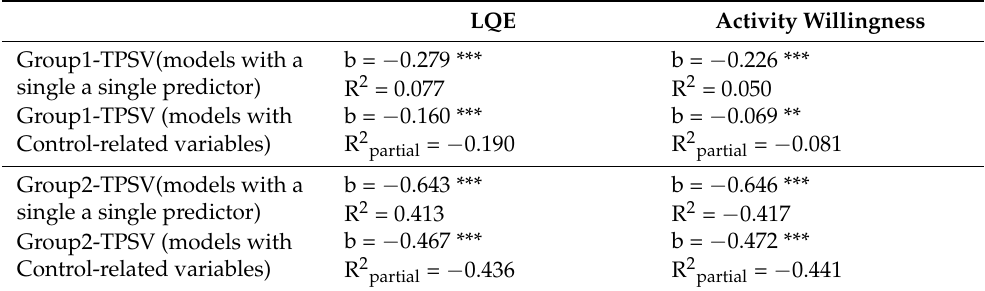
Table 11. Regression coefficients of the two groups on LQE on activity willingness (note: R 2 partial is the correlation coefficient after controlling for other variables, *** p ≤ 0.001, ** p ≤ 0.01). LQE Activity Willingness Group1-TPSV(models with a b = − 0.279 *** b = − 0.226 *** single a single predictor) R 2 = 0.077 R 2 = 0.050 b = − 0.160 *** b = − 0.069 ** Group1-TPSV (models with Control-related variables) R 2 partial = − 0.190 R 2 partial = − 0.081 Group2-TPSV(models with a b = − 0.643 *** b = − 0.646 *** single a single predictor) R 2 = 0.413 R 2 = − 0.417 b = − 0.467 *** b = − 0.472 *** Group2-TPSV (models with Control-related variables) R 2 partial = − 0.436 R 2 partial = − 0.441